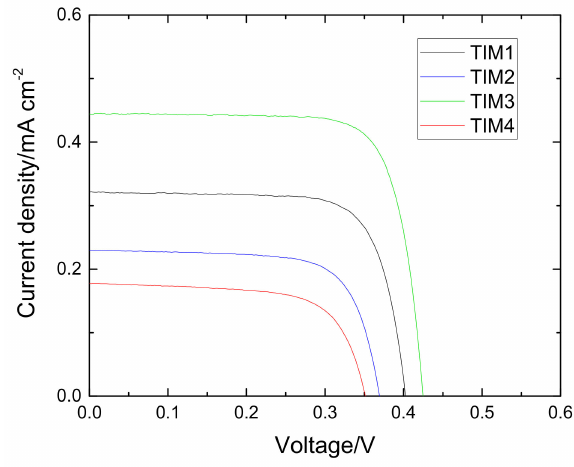
Figure 5. Di ff use reflectance of TIM1 – 4 -coated TiO 2 photoanodes. The light was irradiated from the non-FTO side. The irradiated area was fixed with a metal aperture to 0.0625 cm 2 and an alumina block was placed at the back of the sample to exclude any transmittance. The y -axis shows the relative di ff use reflectance, by shifting the tail of the longer-wavelength peak (800 nm) to 1.